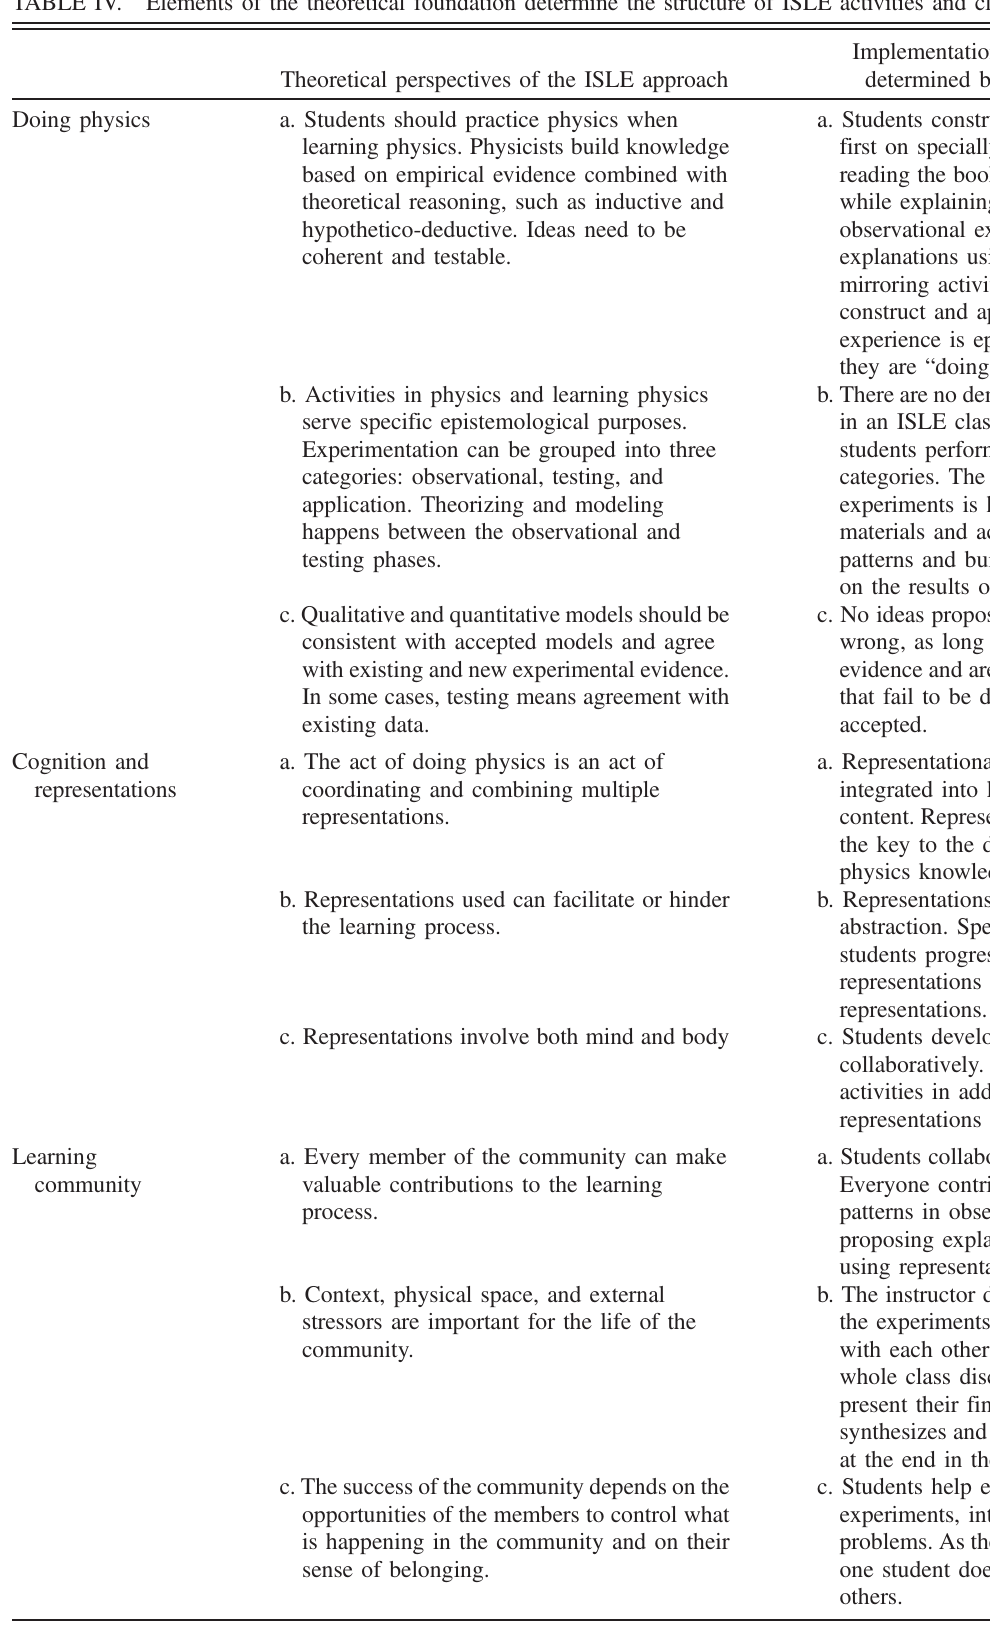
TABLE IV. Elements of the theoretical foundation determine the structure of ISLE activities and class